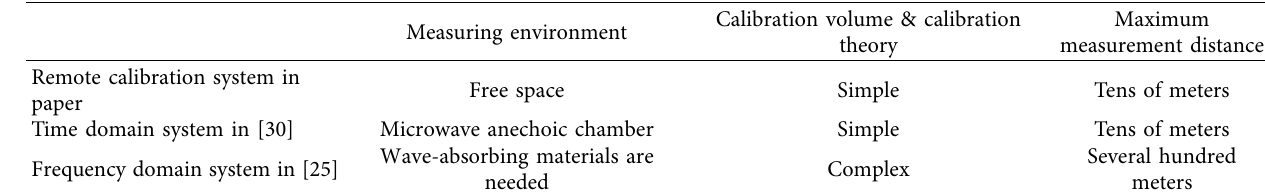
Table 2: Compare the performance of diferent